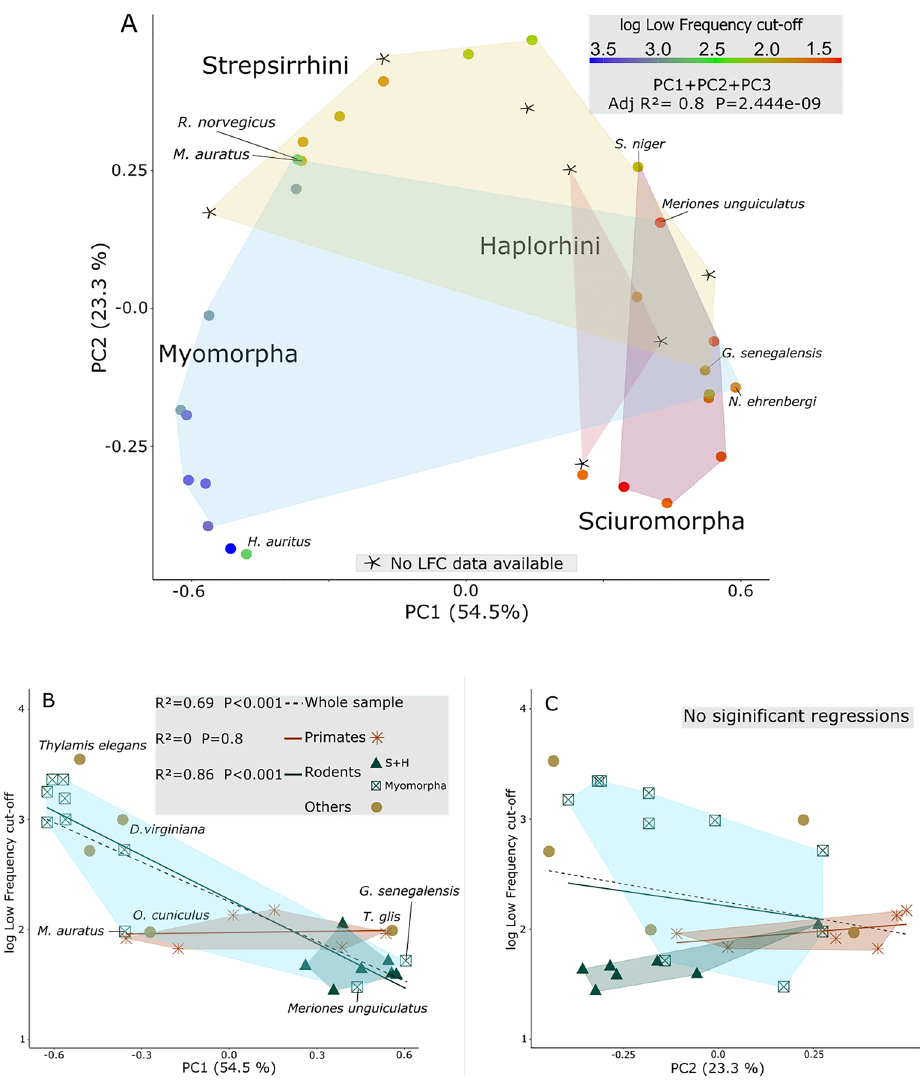
Figure 5. Relationships between principal components of shape and low-frequency cut-off. ( A ) PC1-PC2 scatterplot, using low frequency cut-off values to color the points. ( B ) Scatterplot of PC1 against low frequency cut-off, with additional independent regression values for each separate group. ( C ) Scatterplot of PC 2 against low frequency cut-off. Regression values were obtained by building PGLS